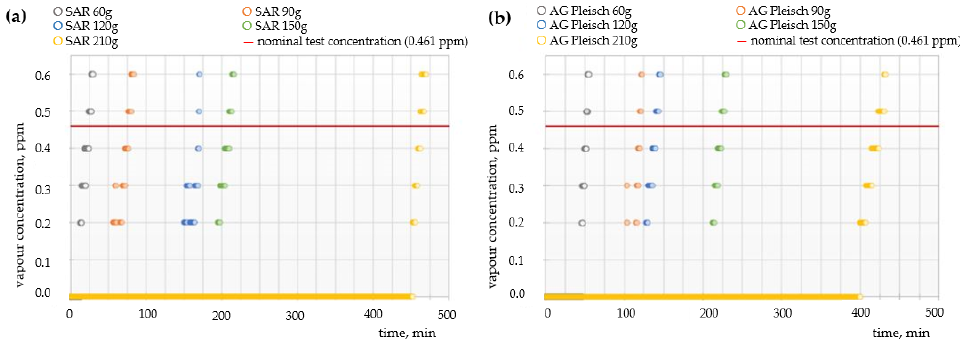
Figure 6. Breakthrough time curves of sulfur oxide vapors for filtration fabrics with different contents of ( a ) SAR and ( b ) AG Pleisch sorbents.